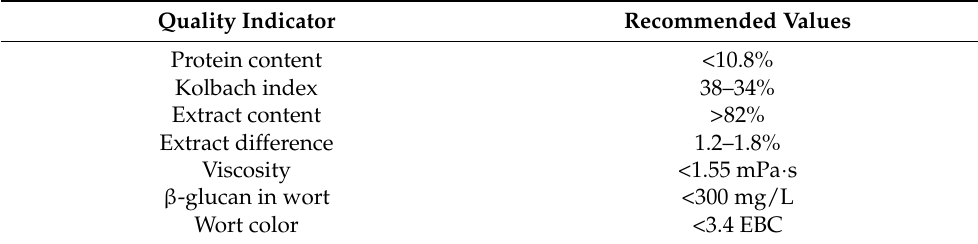
Table 1. Malt-quality indicators. Quality